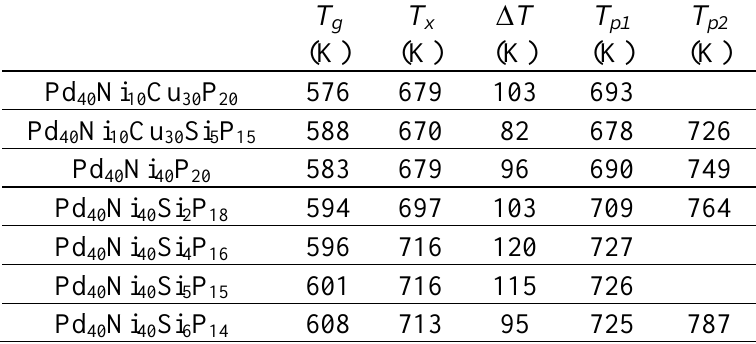
Ni Cu Si P (x = 0 and 5) 40 10 30 x 20−x